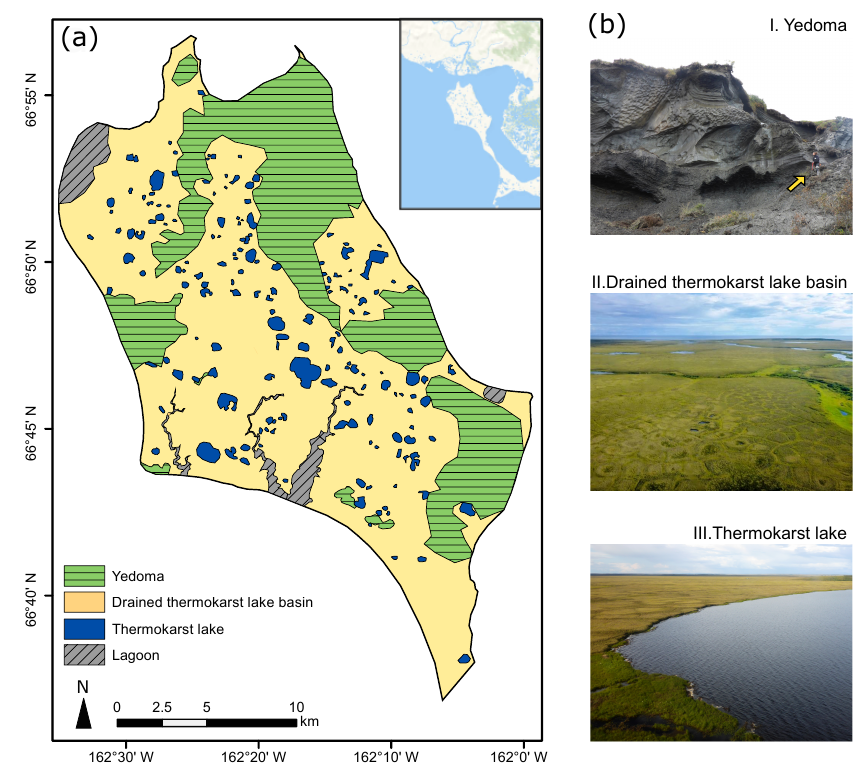
Figure 4. (a) Land cover classification map of Baldwin Peninsula (see overview map in upper-right corner) with yedoma (green), drained thermokarst lake basins (yellow), thermokarst lakes (blue) and lagoons (grey). (b) Exemplary photos: I. Yedoma (note person on the right indicated by yellow arrow for scale), II. Drained thermokarst lake basin and III. Thermokarst lake. Source for overview map in (a) is the World Ocean Base (ESRI). Table 3. Input (left) and output parameters (right) for organic carbon pool calculations for yedoma, drained thermokarst lake basin and thermokarst lake deposits: deposit thickness, landscape coverage, wedge-ice volume (WIV). WIV data from Ulrich et al. (2014). Volumetric OC and TOC pools including and excluding WIV. Volumetric OC TOC Volumetric OC TOC Landscape unit Thickness Coverage WIV pool Incl. WIV pool Incl. WIV pool excl. WIV pool excl. WIV (m) (m 2 ) (vol%) (kgm − 3 ) (Mt) (kgm − 3 ) (Mt) Yedoma 15 136620000 48 DTLB 296440000 Thermokarst lake 2 21180000 0 92 . 9 ± 0 .